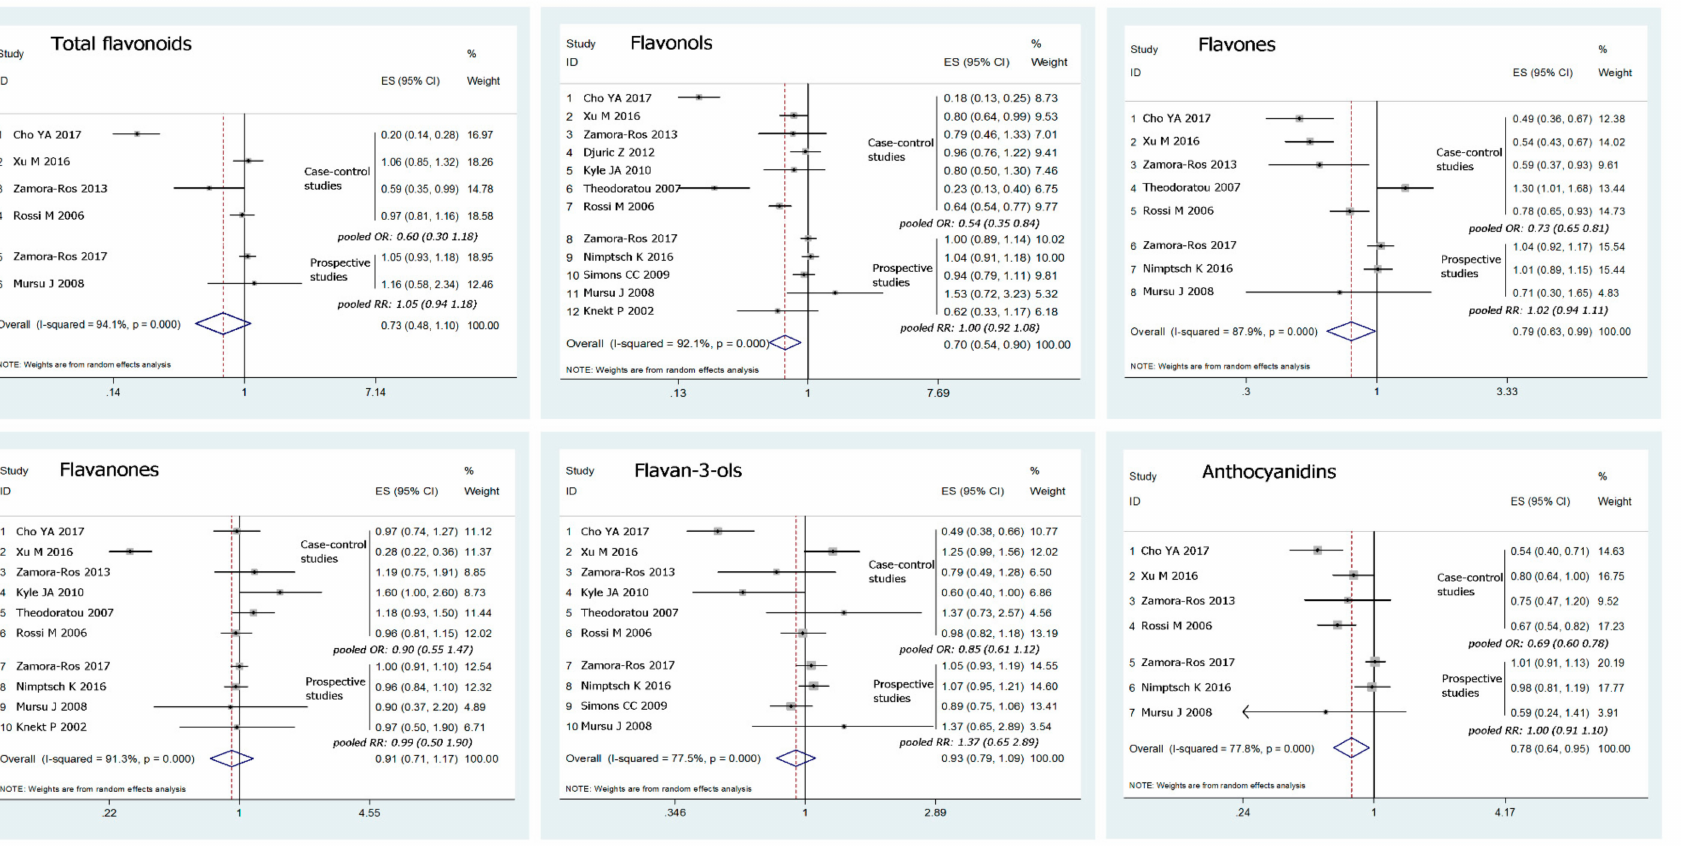
Figure 2. Forest plots of investigating association for flavonoids intake with colorectal cancer risk (highest vs. lowest). Squares indicate study-specific risk estimates (size of the square reflects the study-specific statistical weight, i.e., the inverse of the variance); horizontal lines indicate 95% confidence intervals (CIs); a diamond indicates summary estimate with its corresponding 95%